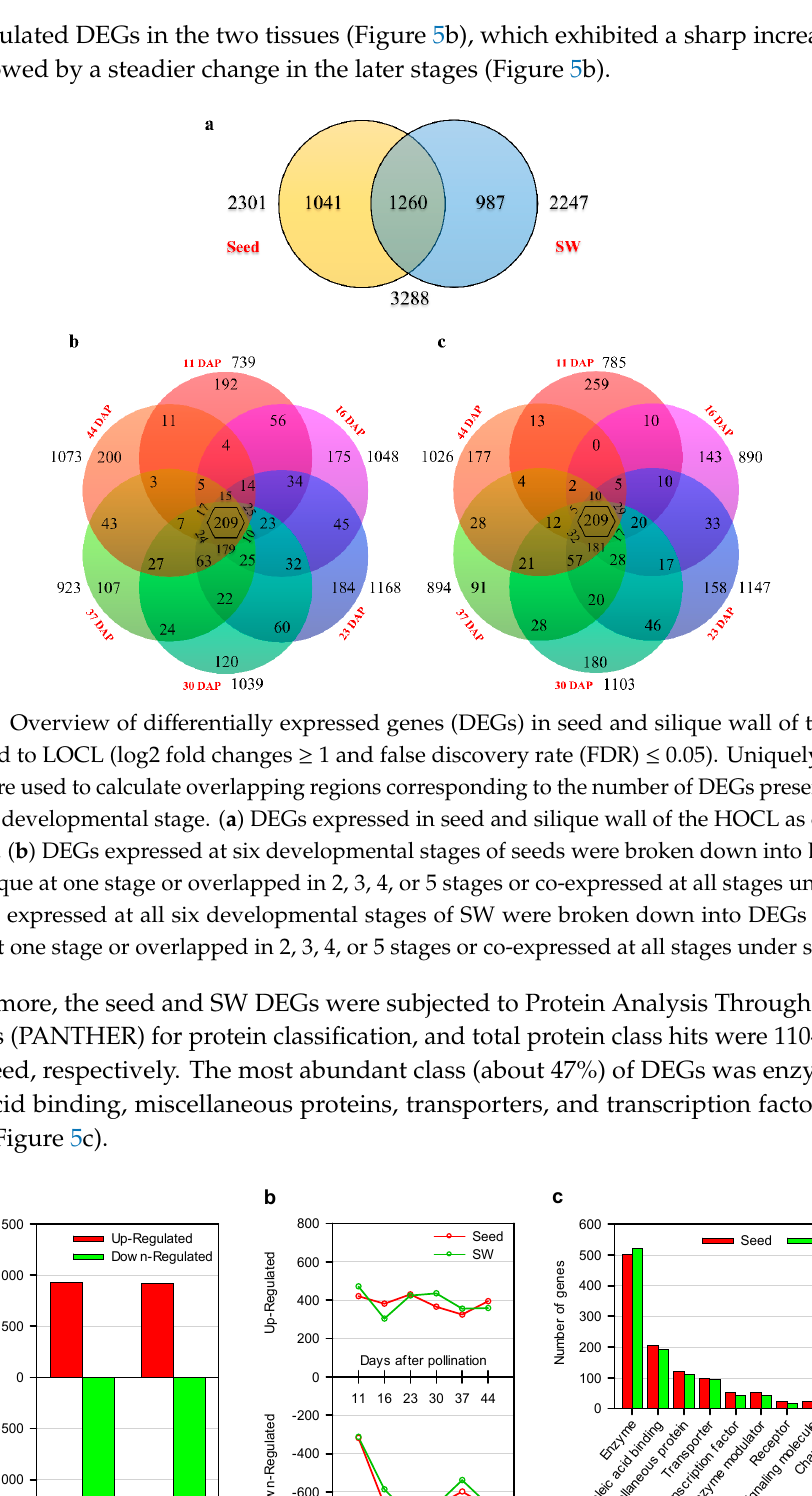
both lines at 23 and 37 DAP. Gene copy–specific primers were used for all selected DEGs to verify the expression pattern by qRT-PCR and data were normalized by UBC-10 and actin genes independently (primer details are given in Supplementary Table S9). For direct comparison with RNA-Seq data, the relative expression quantified by qRT-PCR was transformed to log2 fold change (HOCL/LOCL). With both reference internal genes, the expression pattern of selected DEGs by RNA- Seq and qRT-PCR was highly correlated ( R = 0.843–0.908 individually and overall correlation of 0.87 (Figure 6i)) at all selected developmental stages in both tissues (Figure 6), further confirming the reliability and consistency of our RNA sequencing data.